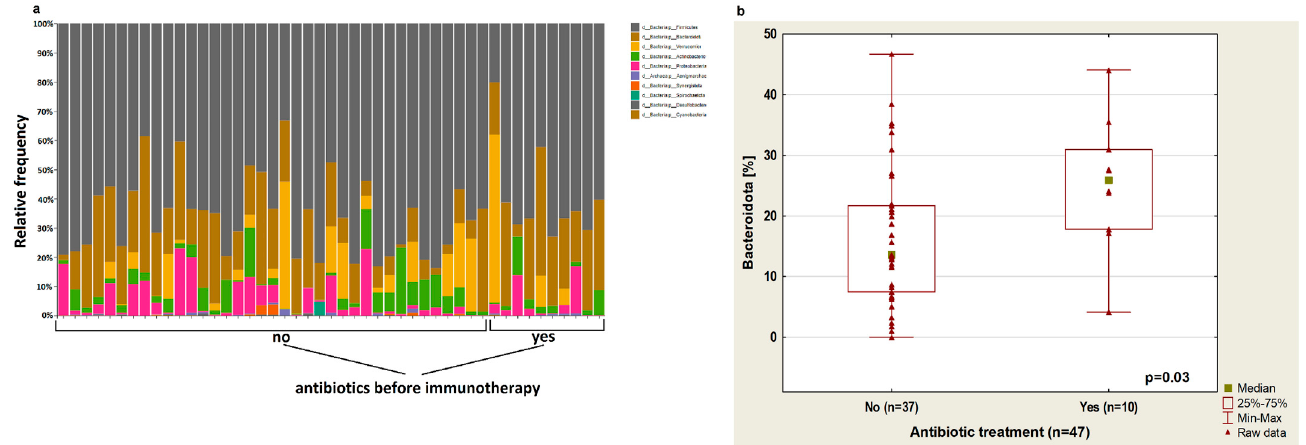
Figure 1. ( a ) Plot showing the relative frequency of bacterial phylum based on 16S rRNA of 47 stool samples from NSCLC patients treated or not treated with antibiotics; ( b ) boxplot showing Bacteroidota content depending on antibiotic therapy up to 4 weeks before immunotherapy.